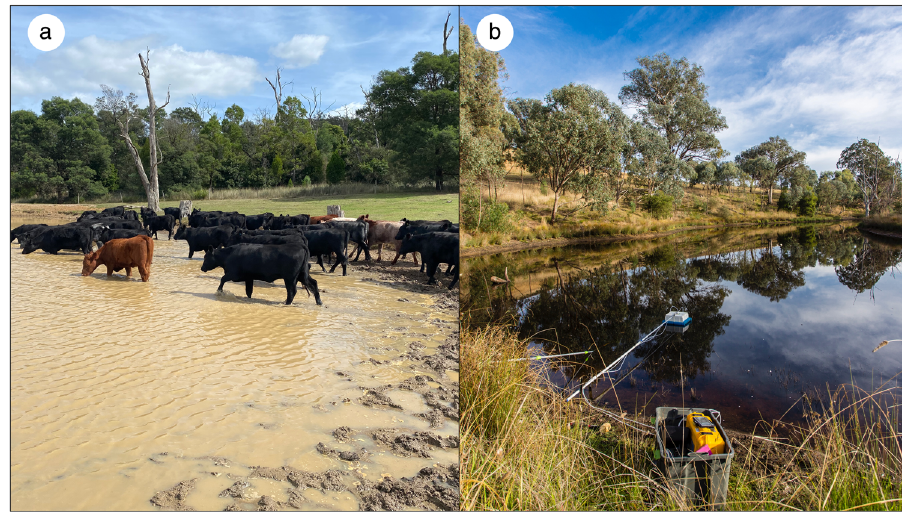
Fig. 4 Managing agricultural ponds to reduce their methane emissions. a Livestock manure and fertiliser often accumulate in agricultural ponds to create ideal conditions for methane production. Image credit: Martino E. Malerba b Simple management interventions, such as fencing to exclude livestock, are cost-effective solutions for reducing these emissions while providing additional environmental bene fi ts (e.g., higher water quality, biodiversity, agricultural productivity, and aesthetic value) 22 – 24 . Image credit: I. Noyan